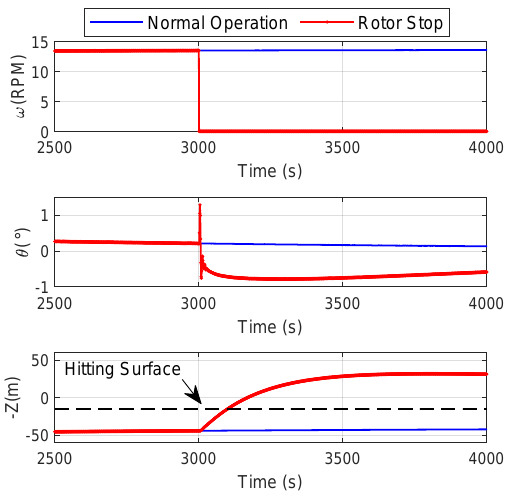
Fig. 6. Time histories of the OCT’s equilibrium states, i.e., shaft power, pitch angle θ , and vertical position Z before and after pitch fault at Time = 2000 at the turbulence intensity of 10